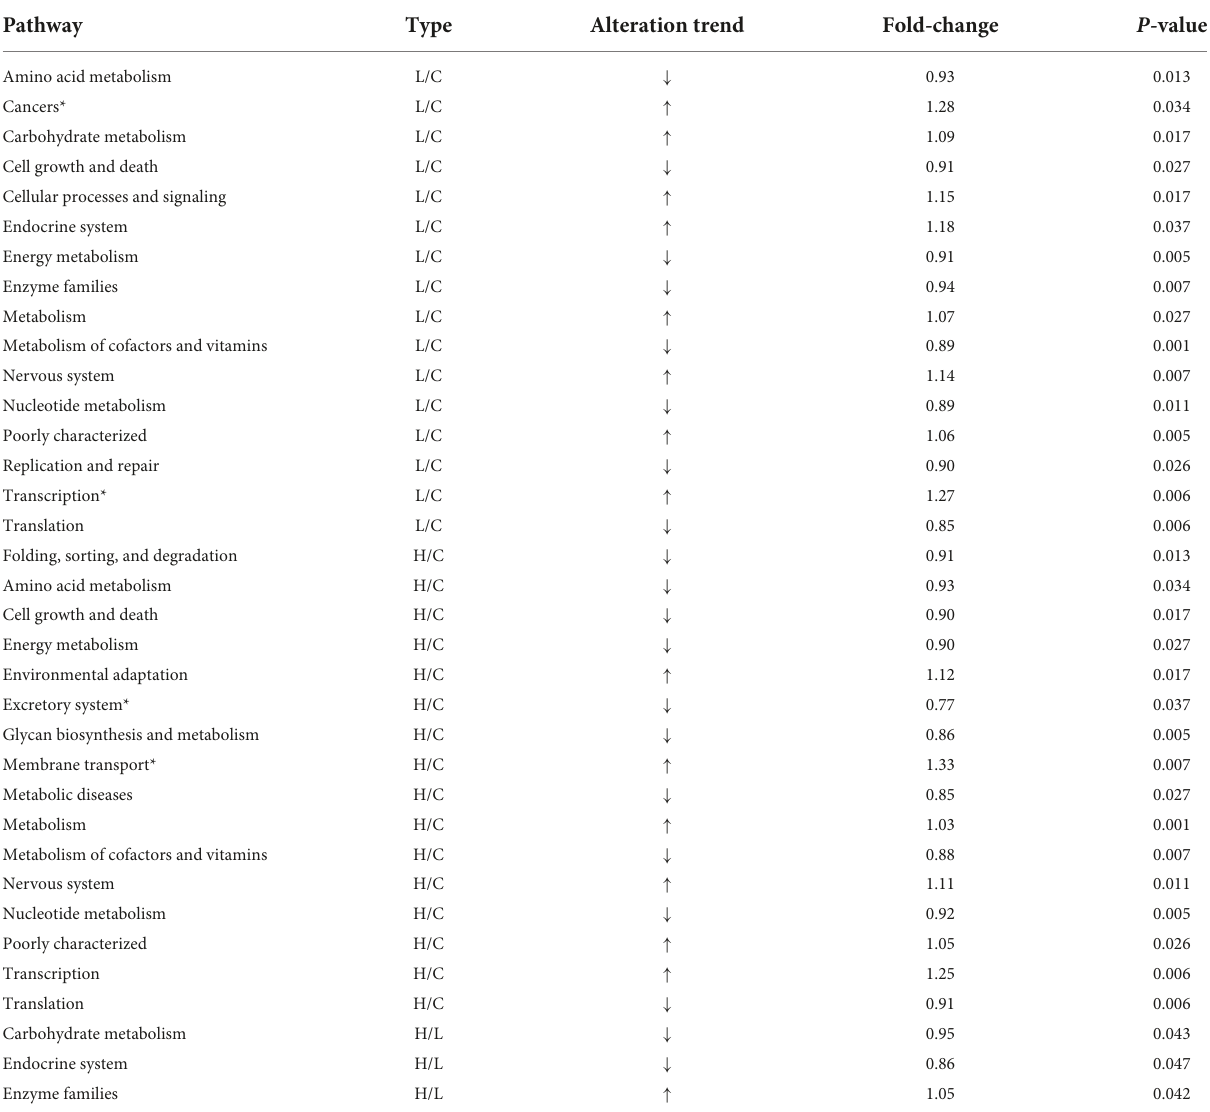
TABLE 2 Significant changed pathways in different groups.